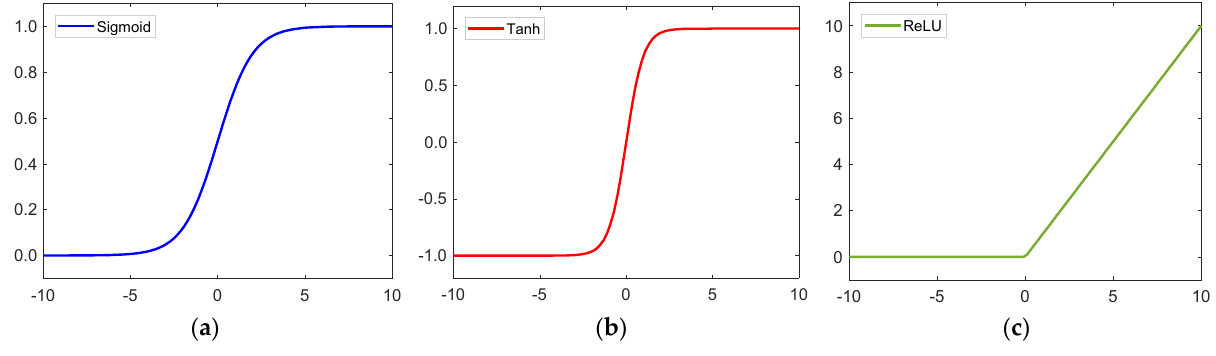
Figure 3. Three activation functions: ( a ) Sigmoid; ( b ) Tanh; ( c ) ReLU.